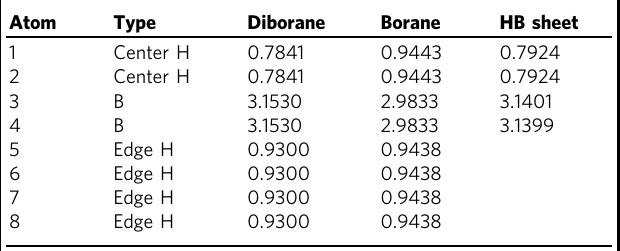
The unit of charge is e . The total valency of H and B are 1 e and 3 e , respectively.